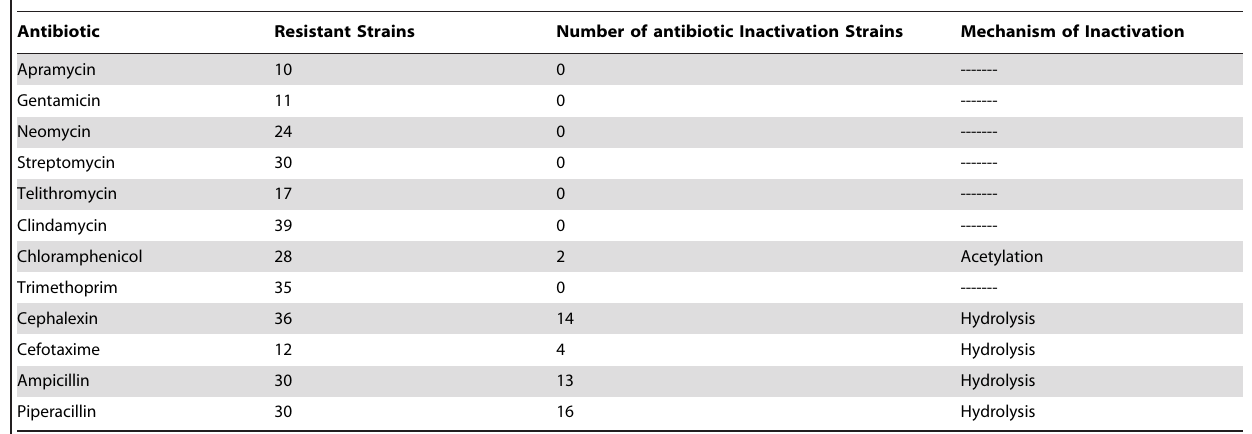
Table 2. Summary of Antibiotic Inactivation Studies for Gram-Negative Isolates.